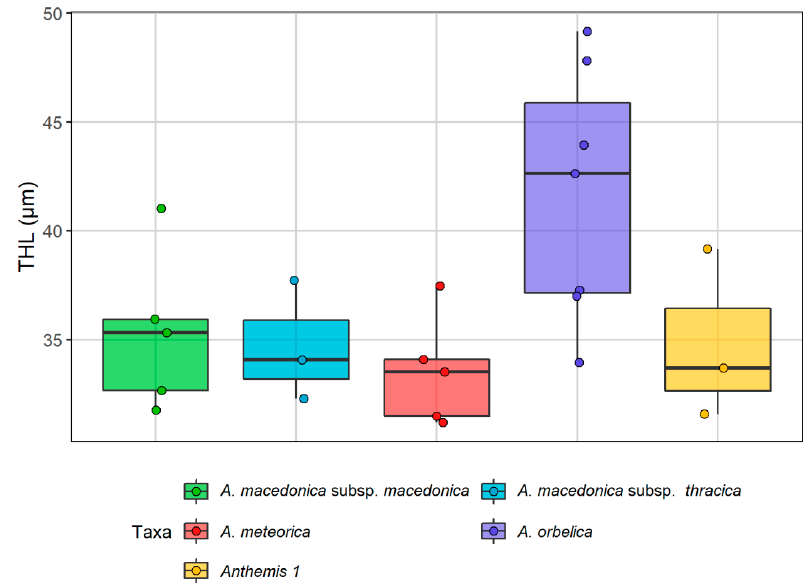
Figure 8. Box plots presenting the variation of the total haploid length (THL) in five different taxa of the Anthemis macedonica group. The coloured points present the individuals’ values for each taxon.